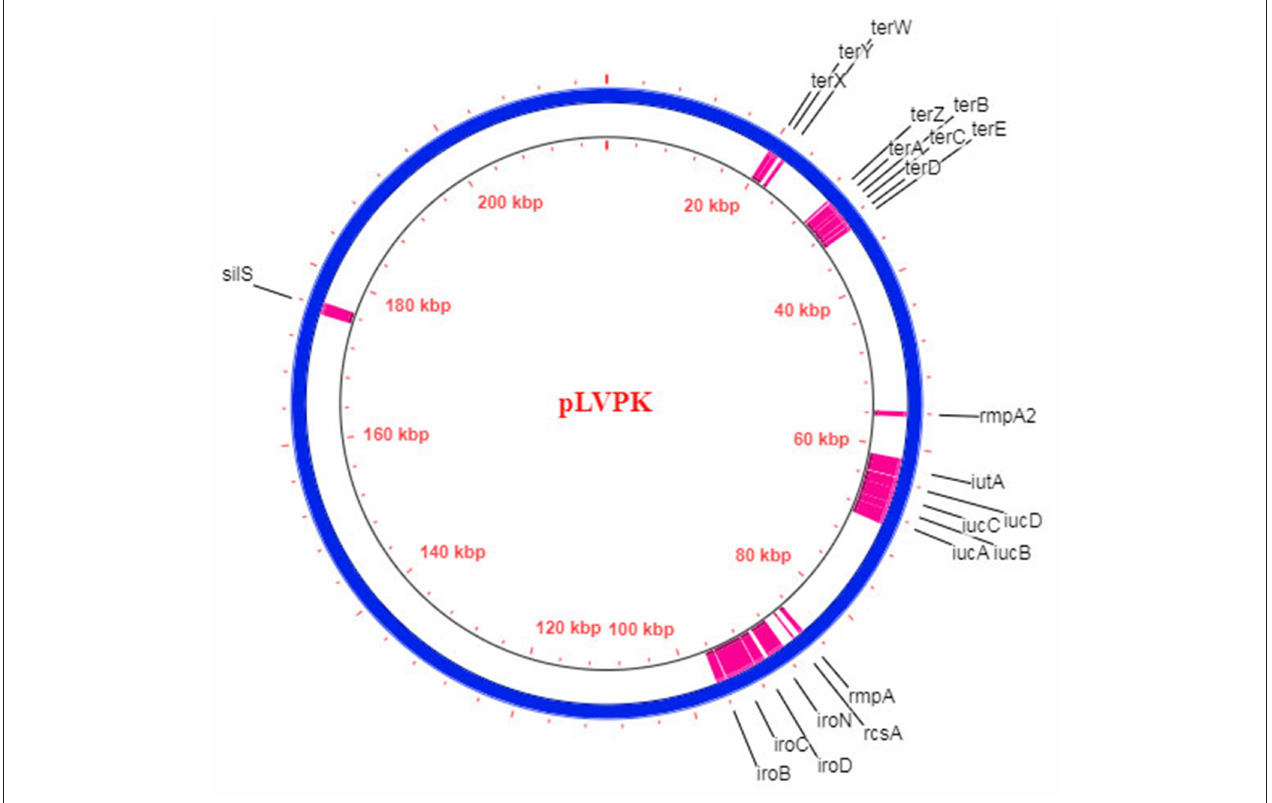
FIGURE 2 | Schematic diagram of the hvKP virulence plasmid pLVPK (Blue circle; 219,385 bp) (35). The respective CDS of the hypervirulent biomarkers are demarcated in